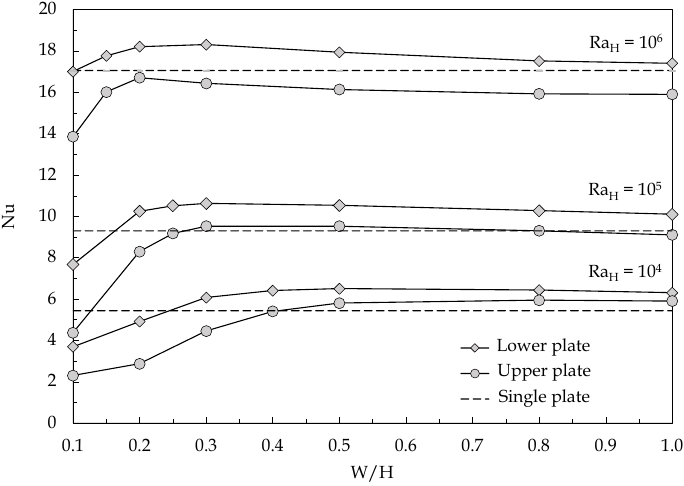
Figure 7. Nu vs. W / H for L / H = 0.5 using Ra H as the parameter.